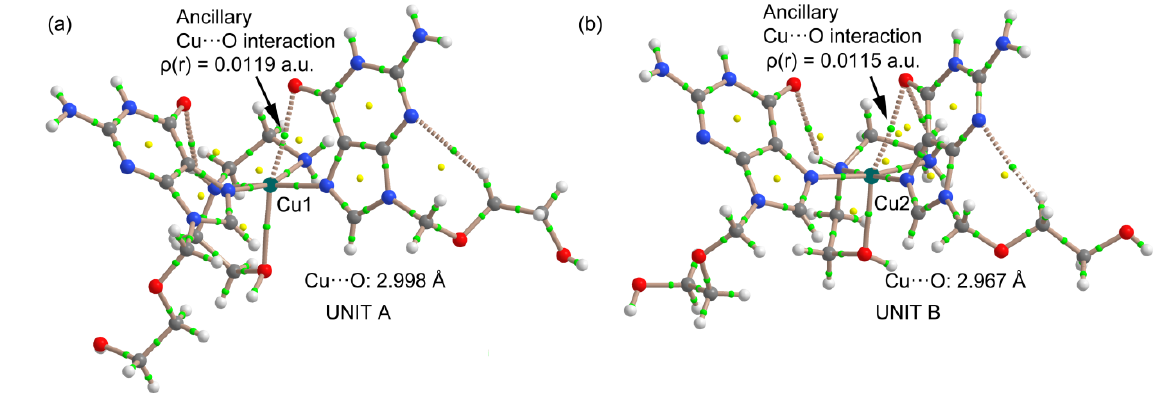
Figure 8. AIM distribution of bond and ring critical points (green and yellow spheres, respectively) and bond paths for units A ( a ) and B ( b ) in compound 3 . Atoms colour code: carbon—grey; hydrogen—white; nitrogen—blue; oxygen—red; copper—dark green, chlorine—light green.